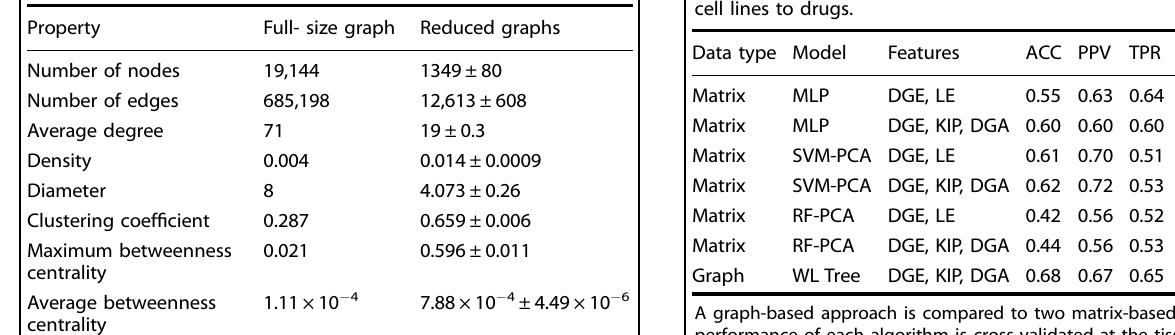
Table 1. Properties of full-size and reduced graphs.